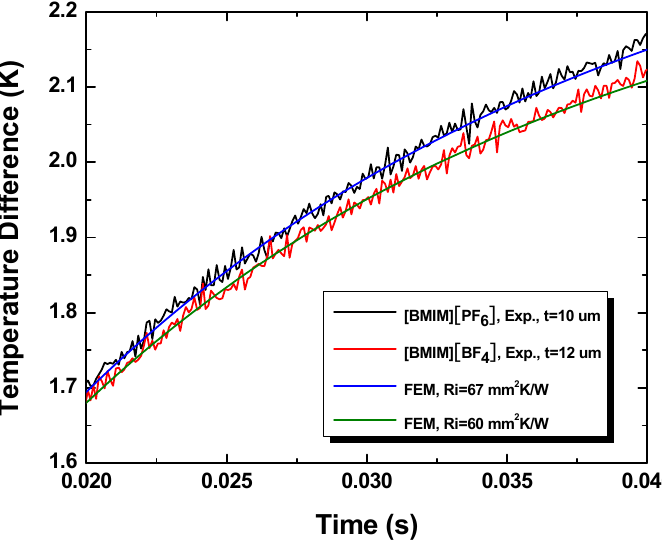
Figure 9. Temporal temperature profiles obtained during experiments and the best fits obtained using finite element